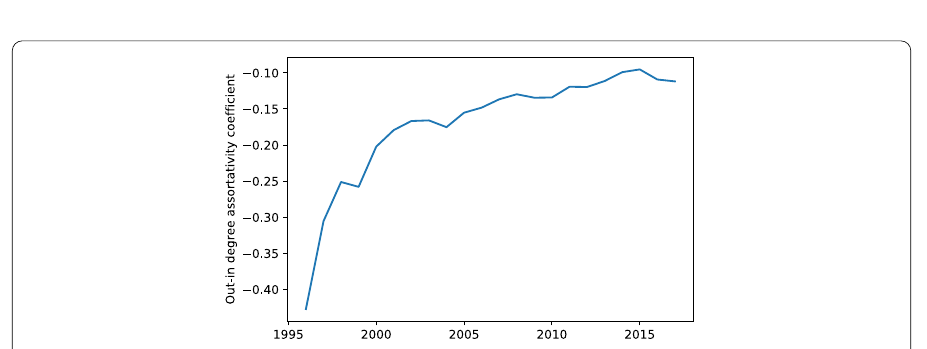
Figure 10 The out-in degree assortativity of the cross-sectional one-year networks showing an overall increase over time